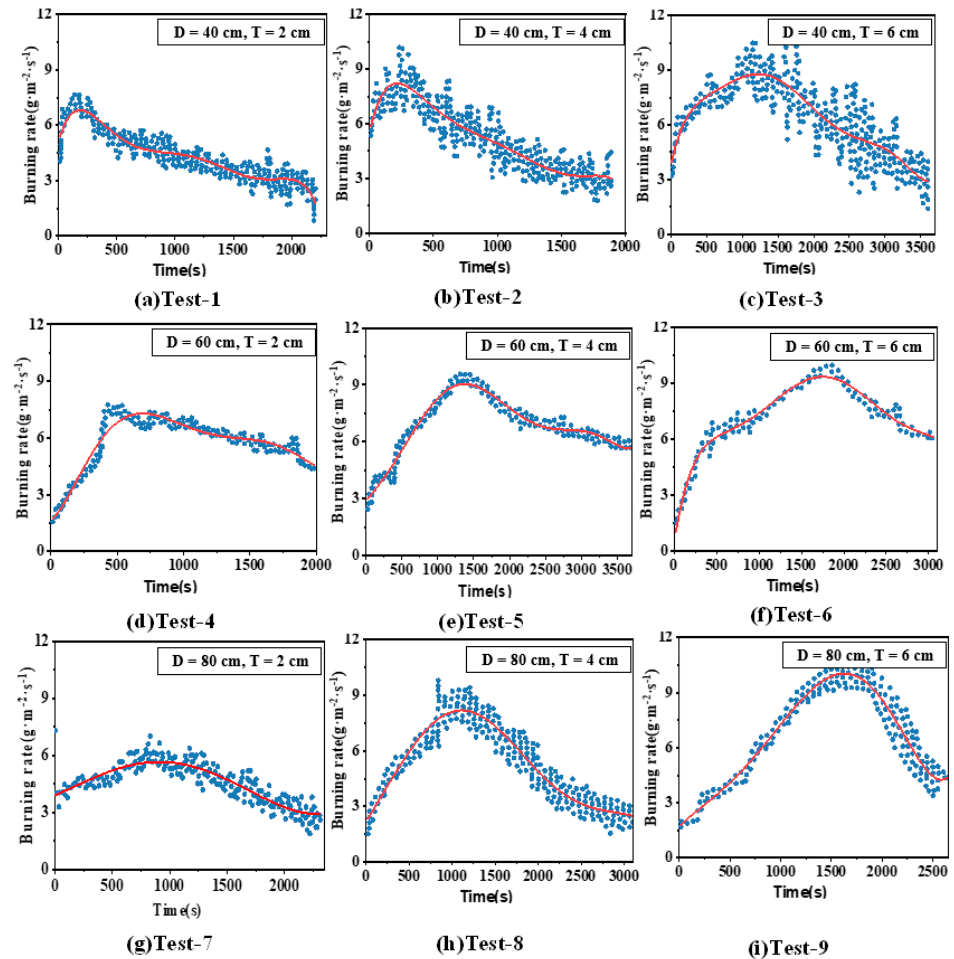
Figure 3. The changes of burning rate from Test-1 to Test-9 (where ( a ) is a coal pile of 40 cm diameter and 2 cm thickness, ( b ) is a coal pile of 40 cm diameter and 4 cm thickness, ( c ) is a coal pile of 40 cm diameter and 6 cm thickness, ( d ) is a coal pile of 60 cm diameter and 2 cm thickness, ( e ) is a coal pile of 60 cm diameter and 4 cm thickness, ( f ) is a coal pile of 60 cm diameter and 6 cm thickness, ( g ) is a coal pile of 80 cm diameter and 2 cm thickness, ( h ) is a coal pile of 80 cm diameter and 4 cm thickness, ( i ) is a coal pile of 80 cm diameter and 6 cm thickness).